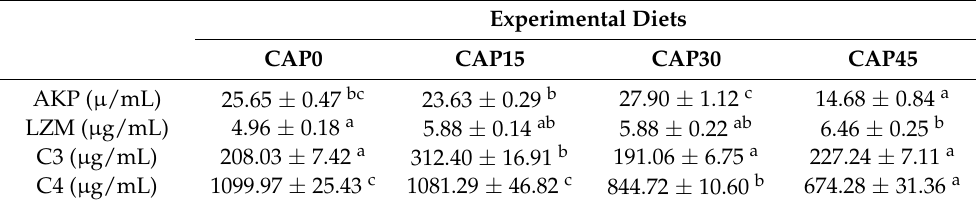
Table 5. Serum immunity indexes of large yellow croakers fed diets with different levels of CAP for 56